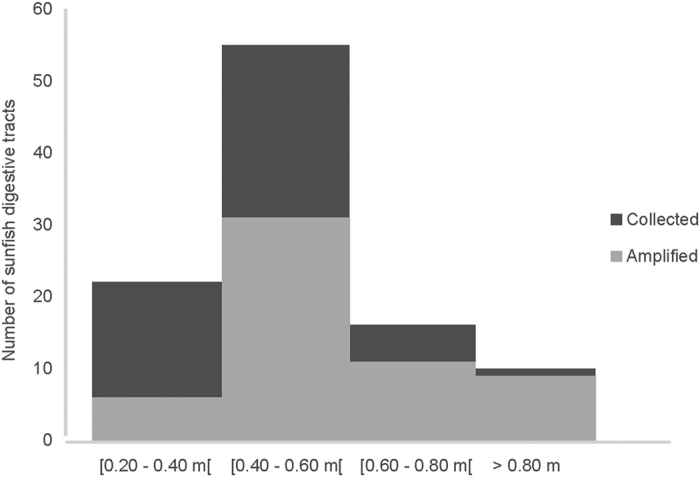
Individual sunfish sizes classes, from which digestive tracts were collected (black) and respectively amplified (grey).